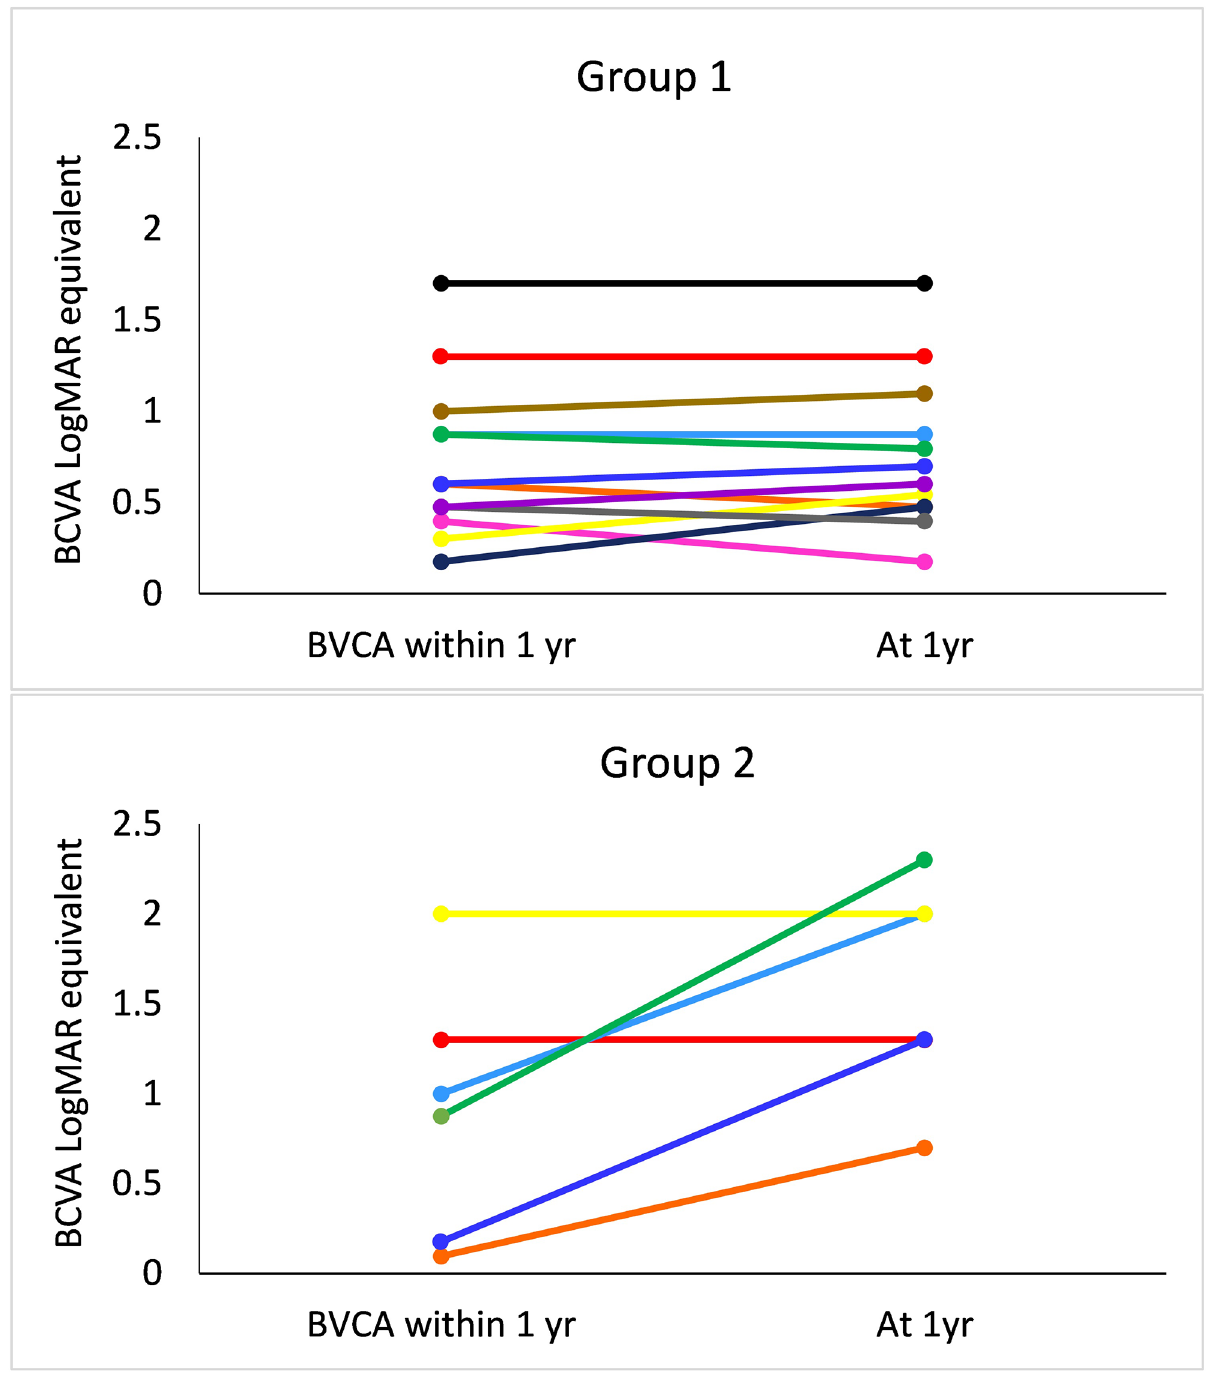
Fig 2. Best corrected visual acuity (BCVA) for patients with or without prior or concurrent glaucoma surgical intervention within 12 months and at 12 months post-Kpro implantation. Individuallines on graphs correspond to individualeyes. Group 1 = patients who had glaucomasurgery prior to or concurrently with Kpro; Group 2 = patients with no history of glaucomasurgery or 3 months post-Kpro.